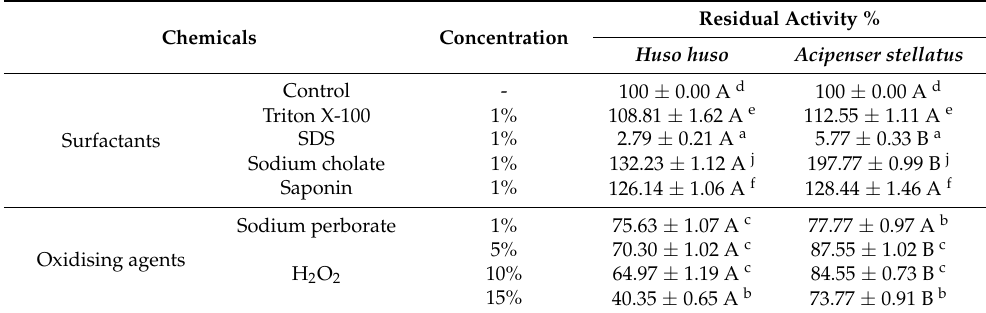
Table 3. Trypsin activity from Huso huso and Acipenser stellatus in presence of surfactants and oxidizing